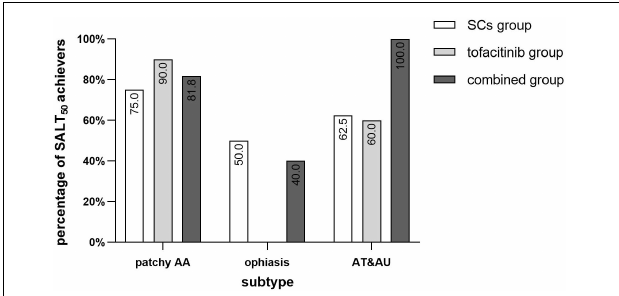
FIGURE 3 | Percentage of SALT 50 achievers of different subtypes of AA in the three groups. SCs, systemic corticosteroids; SALT, Severity of Alopecia Tool; AA, alopecia areata; AT, alopecia totalis; AU, alopecia